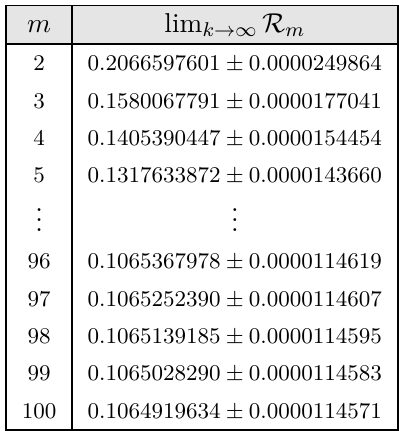
Figure 6. Variation of Rényi entropies for the state | 3 1 # T 2 , 2 i with k .